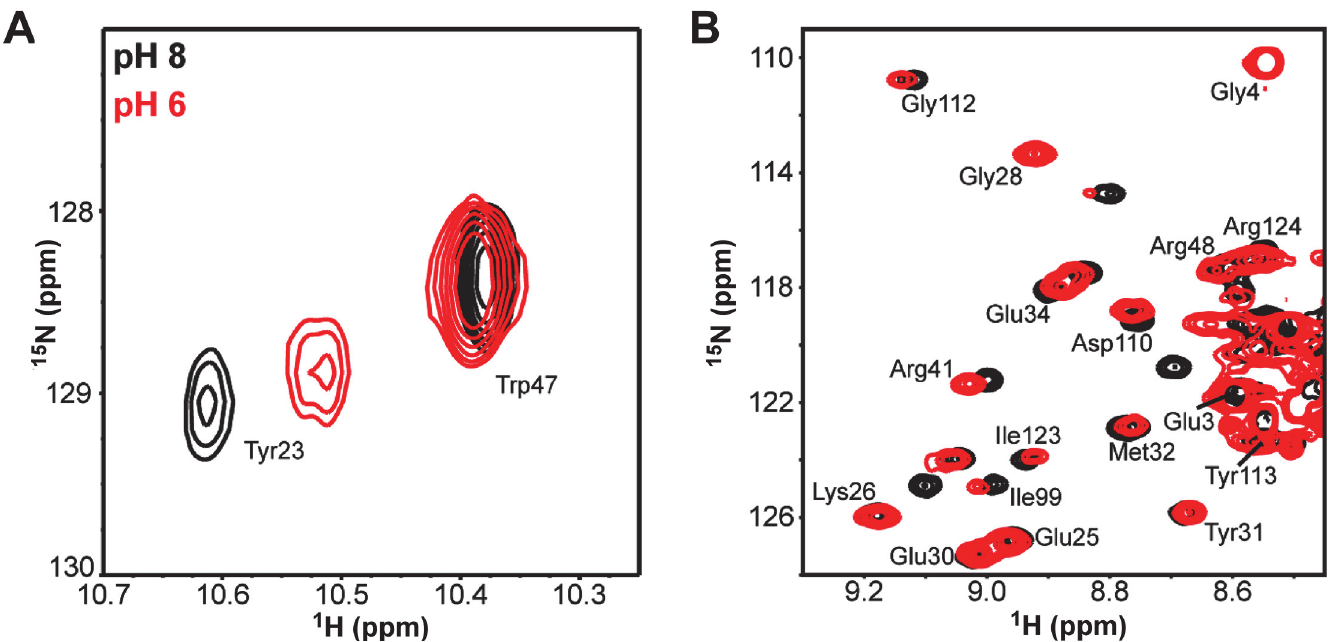
Fig 5. DksA structure is sensitive to pH. Two-dimensional 1 H- 15 N HSQC spectra at pH 8 (black) and 6 (red) reveal large chemical shift changes at (A) Tyr23 and (B) many other